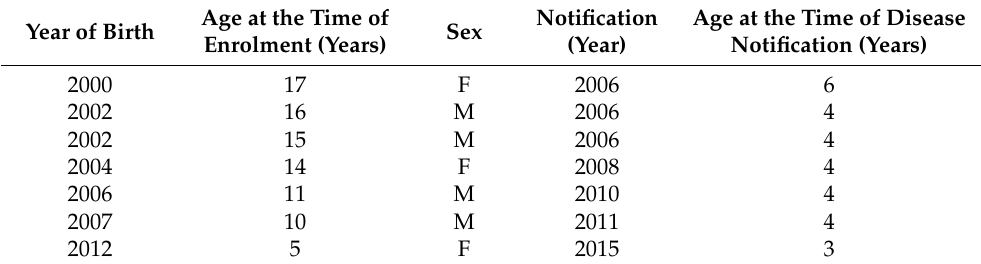
Table 2. Notification of varicella disease according to The National Registry of Notifications for Infectious Diseases (SIMI).